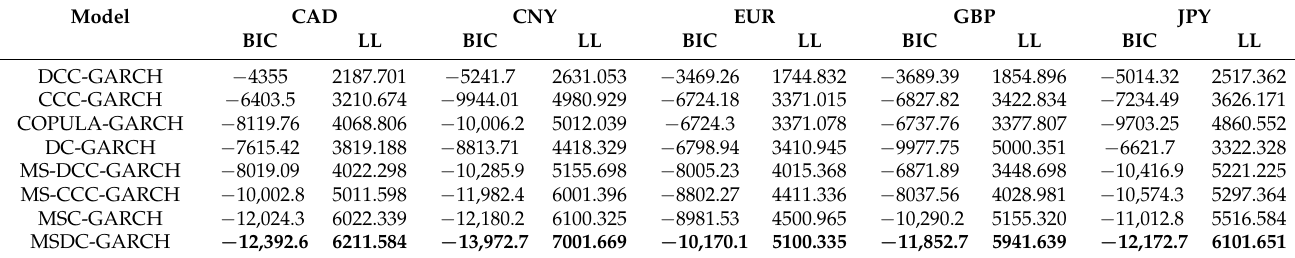
Table 7. BIC and Log-likelihood (LL) values for different models fitted to the 5-min returns of five currencies. Model DCC-GARCH